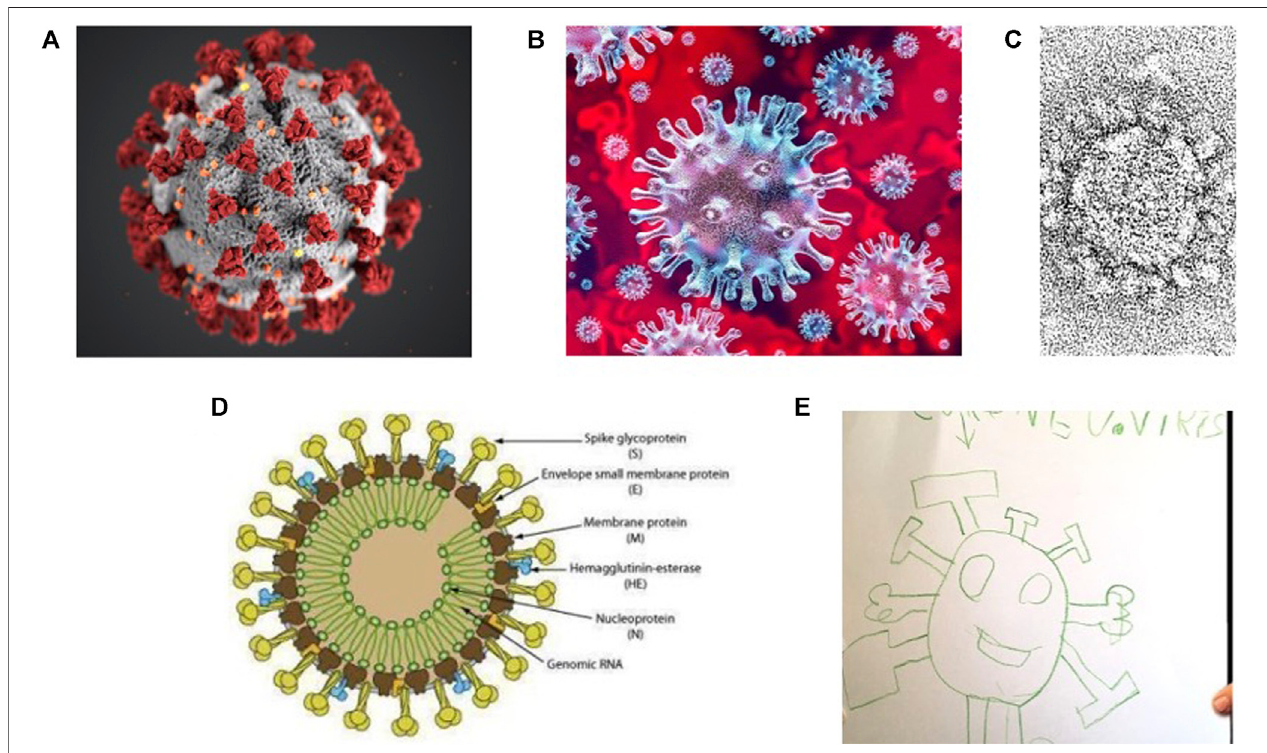
FIGURE2| StaticVisualrepresentations (A) StylisedCovid-19ultrastructuralmorphology(Eckert&Higgins,2020) (B) StylisedanddecorativeillustrationofCovid- 19 virions, (WebMD, 2021) (C) Electron microscopic image of a negatively stained particle of Covid-19 (Goldsmith & Tamin, 2020) (D) Scienti fi c “ textbook ” type image including labels and cutaways (Kamde et al., 2020) (E) Child ’ s drawing of the virus (Gaulkin, 2020).